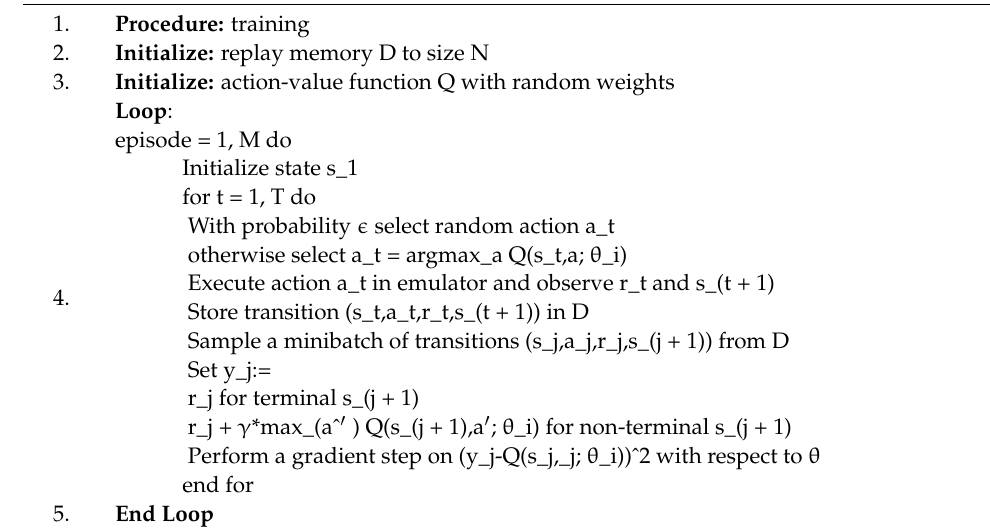
Algorithm 5: PING-PONG Game’s DQN